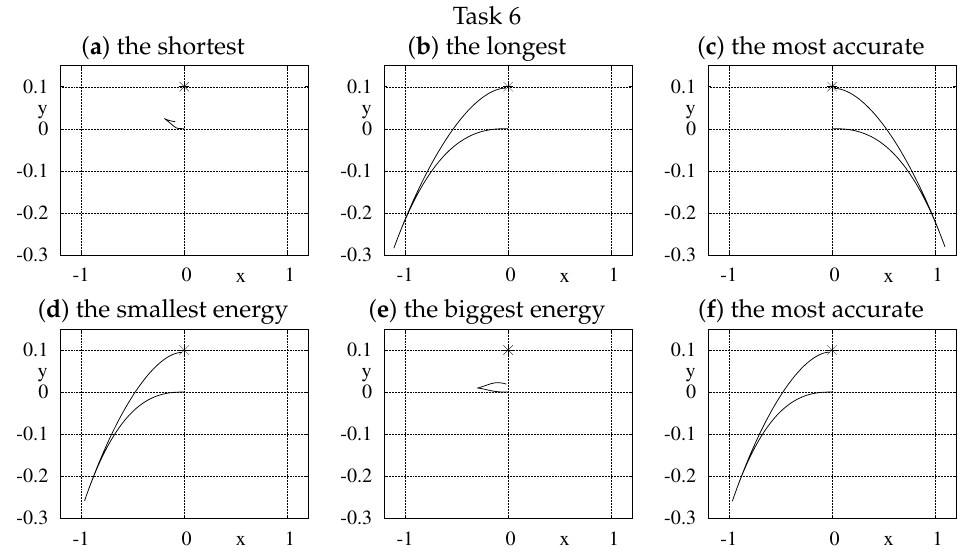
Figure 3. xy -plane projections of some paths generated with basic ( a – c ) and null-space optimization ( d – f ) versions of the Newton algorithm run for the kinematic car. Table 1. Data for tasks. Task No. Model Output Function Controls δ